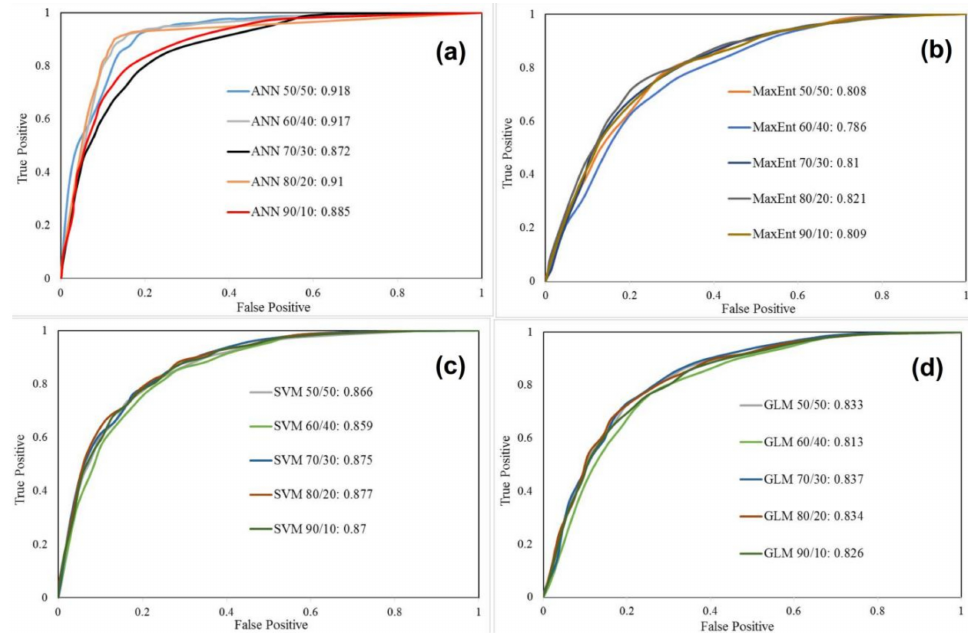
Figure 11. Area under the curve based on training datasets in the ANN ( a ), MaxEnt ( b ), SVM ( c ), and GLM ( d ) model.